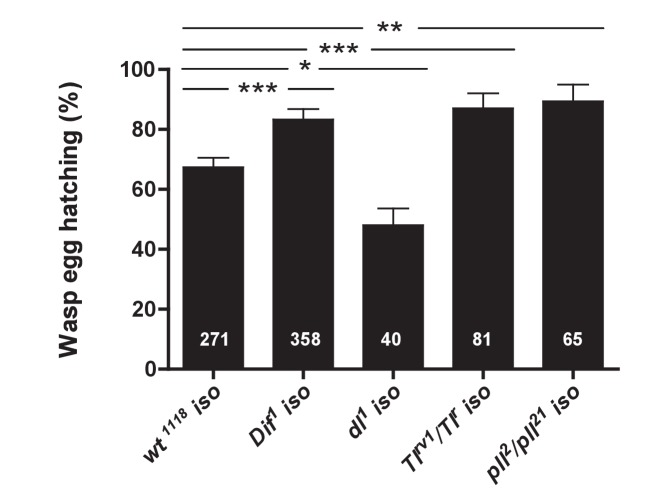
Toll/NF-κB signaling is required for wasp egg encapsulation.Quantification (%) of wasp egg hatching in isogenic strains wt1118 (control), Dif1, dl1, Tlrv1/Tlr and pll2/pll21. Note high level of wasp egg hatching in the wt1118 iso background. Error bars correspond to SEM, *p<0.1, **p<0.01, ***p<0.001 (Pearson’s Chi-squared test).10.7554/eLife.25496.008Figure 2—figure supplement 1—source data 1.Wasp egg hatching quantification.